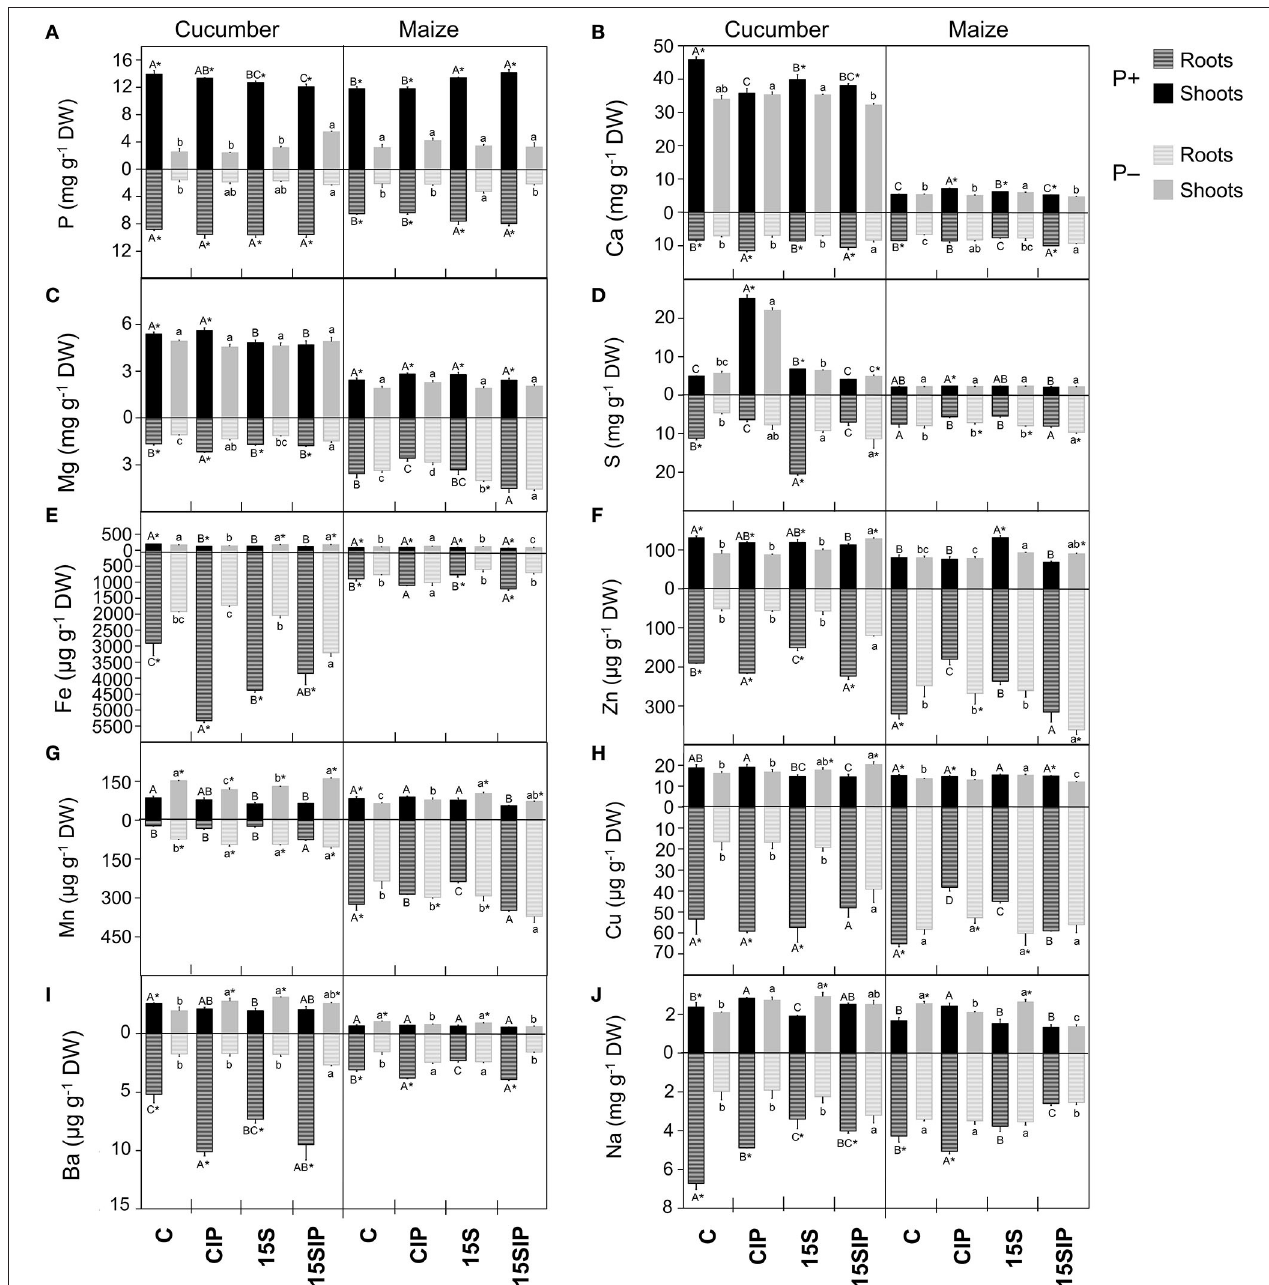
FIGURE 3 | Ionomic profile of cucumber and maize plants tissues. (A) Phosphorus, P; (B) Calcium, Ca; (C) Magnesium, Mg; (D) Sulfur, S; (E) Iron, Fe; (F) Zinc, Zn; (G) Manganese, Mn; (H) Copper, Cu; (I) Barium, Ba; (J) Sodium, Na concentrations in roots and shoots of cucumber and maize grown hydroponically under different P-fertilization levels (P + and P–) and different biostimulant treatments with Enterobacter 15S (C, CIP, 15S, 15SIP). Values are means ± SE; n = 3. Uppercase letters compare treatments under P + , and lowercase letters compare treatments under P–. An asterisk is present when there is a difference in the same treatment between P + and P–. Equal letters correspond to average values that do not differ according to Tukey’s test ( p < 0.05).